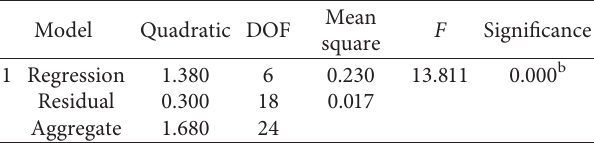
Table 9: Analysis of